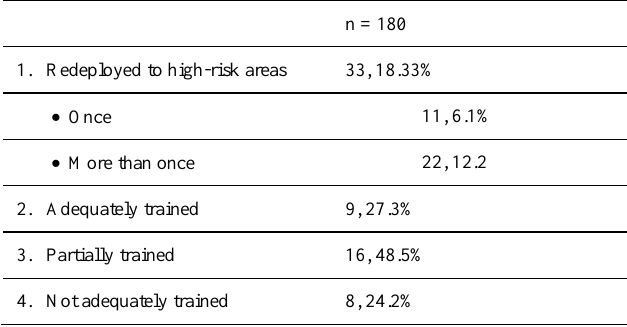
Table 1. Experience of redeployment to high-risk areas